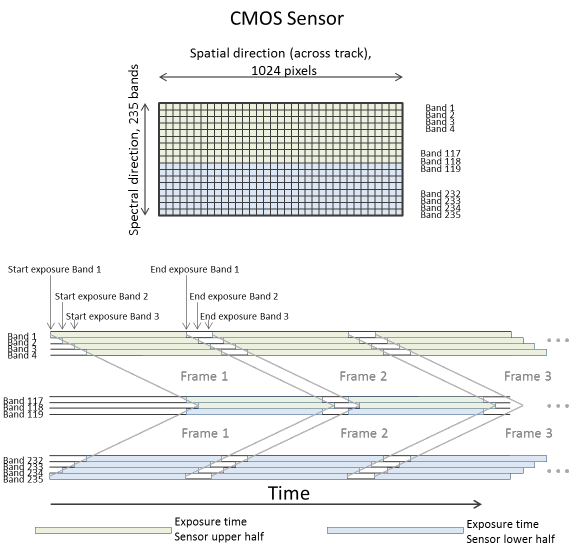
Figure 5. Schematic view of the DESIS CMOS sensor readout